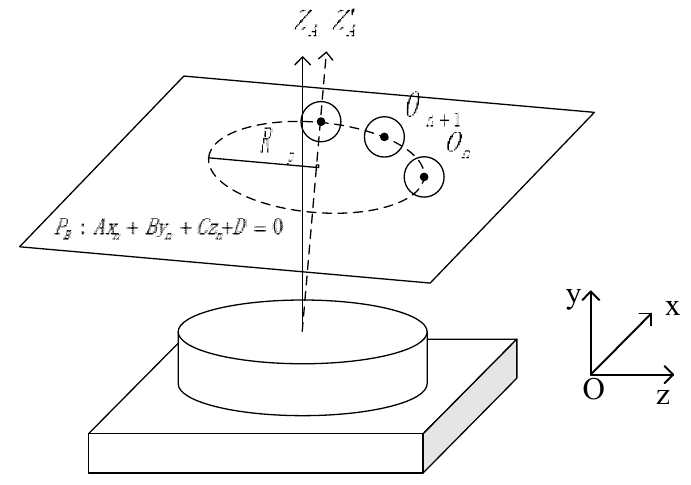
Figure 9. Rotation axis center calibration method.